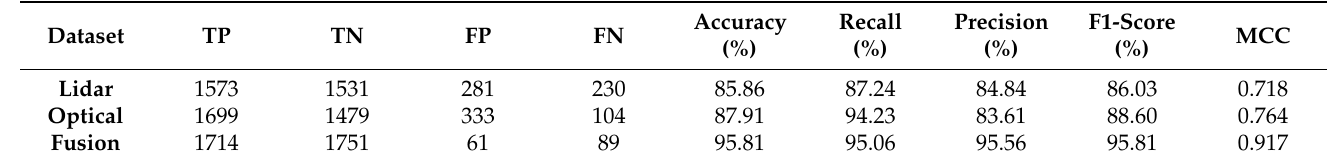
Table 6. The numerical results from BDD-Net for the sample